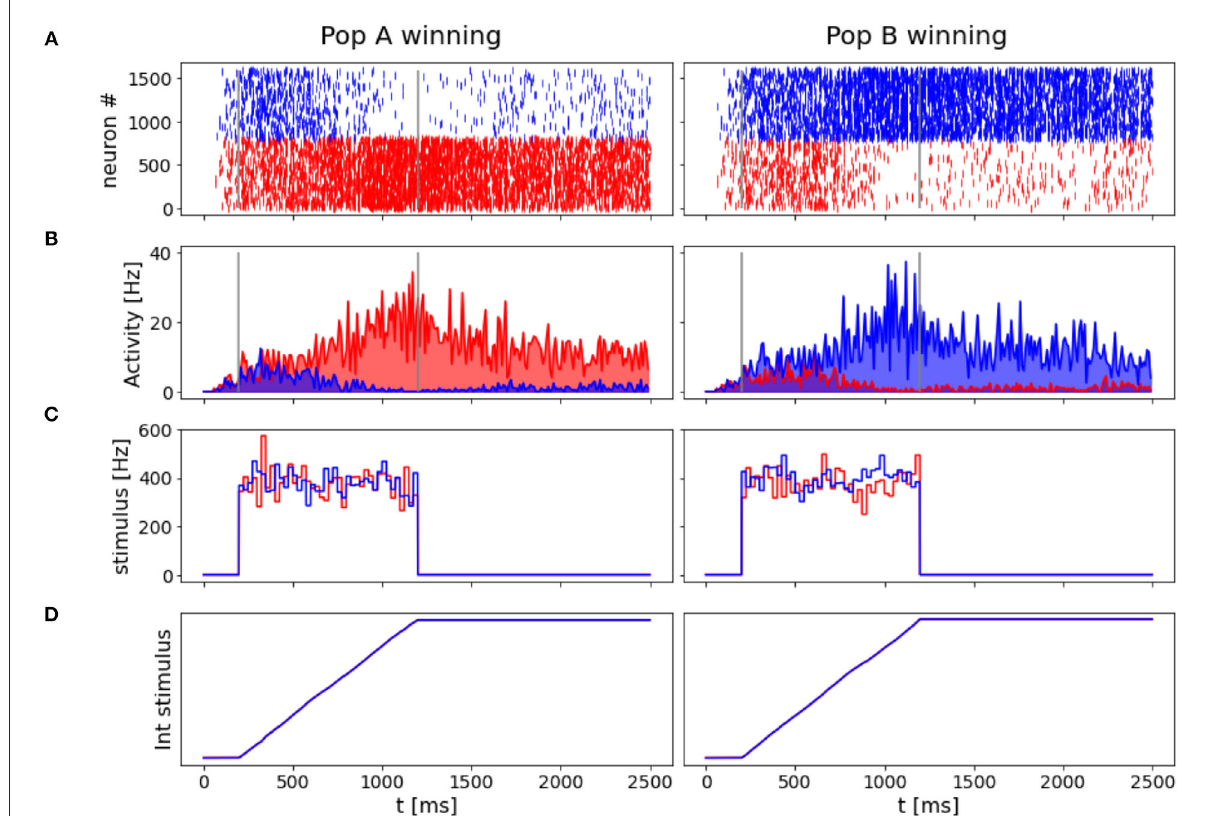
FIGURE6 “Coin toss” decision: Here represented two trials where 0.0% coherence level is given to the network. In the left panels, population A wins over B, on the right, population B wins over A. (A) Raster plots for all excitatory neurons in the network color coded with respect to the population they belong to: in red Population A, in blue population B. (B) Firing rates across time for the two neuronal groups. (C) Input stimuli time course. In blue the stimulus is given to population B, in red the stimulus is given to population A. (D) The time integral of the two